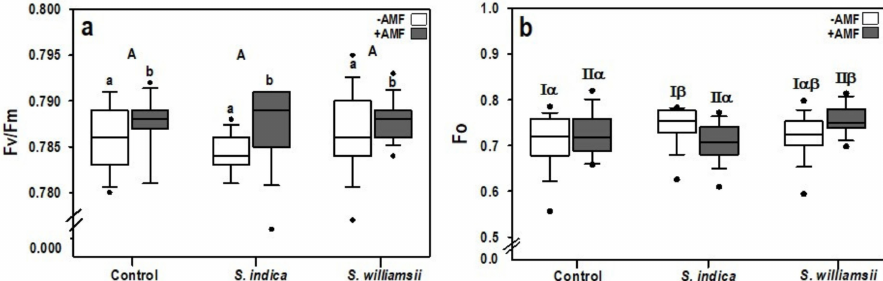
Figure 3. Chlorophyll fluorescence parameters including the maximum photochemical quantum yield of photosystem II (Fv / Fm) ( a ) and the minimal chlorophyll fluorescence yield (Fo) ( b ). Upper-case letters indicate di ff erences in the main factor ‘ Serendipita ’. Lower-case letters indicate di ff erences in the main factor ‘AMF’ (ANOVA, p < 0.05, n = 15). Greek letters were used to highlight significant interaction e ff ects based on the simple e ff ect analysis for − AMF(I) and + AMF(II). Columns followed by the same letters are not significantly di ff erent.